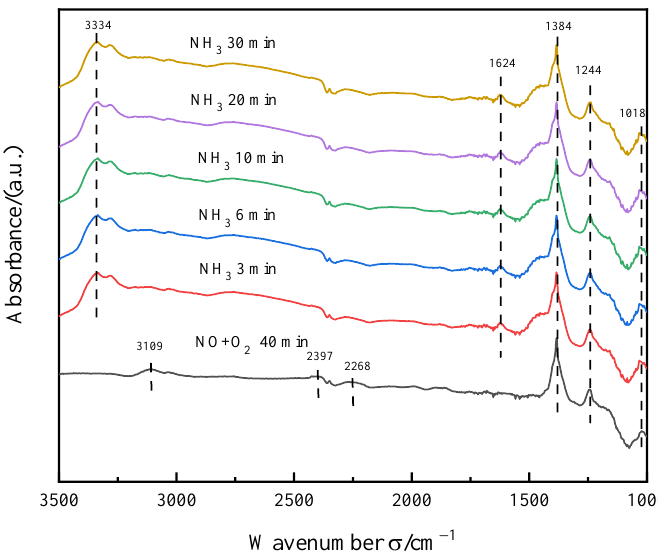
Figure 9. In situ DRIFTS of NH 3 reacting with pre-adsorbed NO+O 2 over the 4Cu-4Ce-4Zr/SAPO- 34 catalyst.